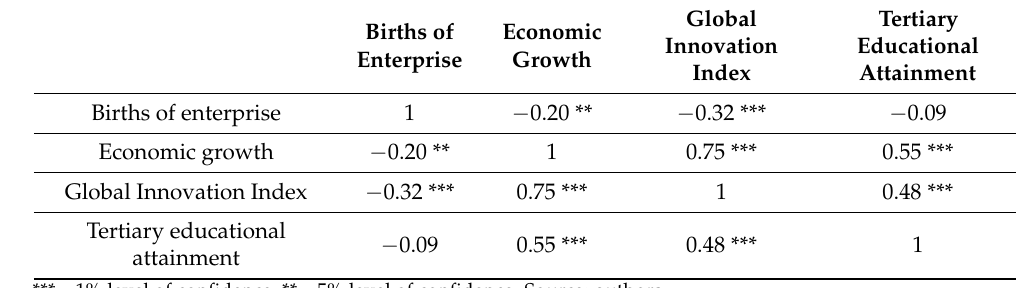
Table 3. Correlation matrix.